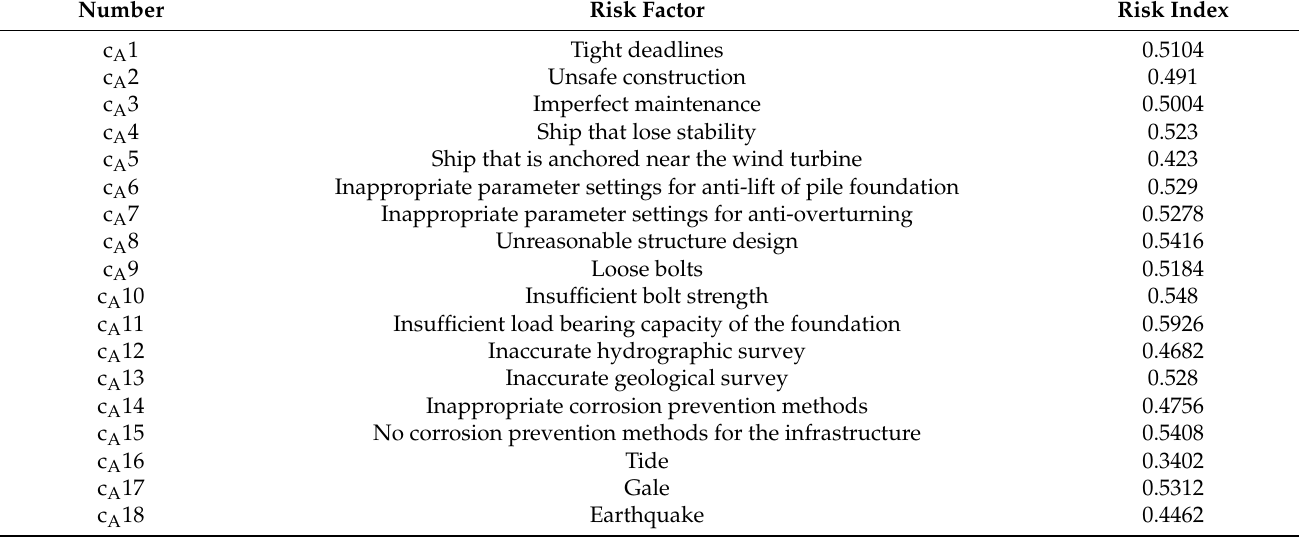
Table 1. Collapse risk factors of offshore wind farms.